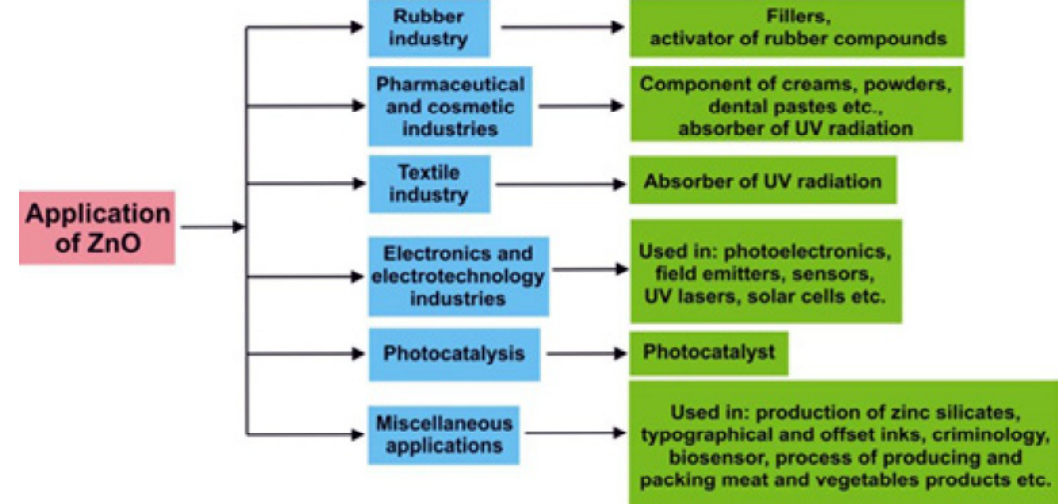
Fig. 11. Schematic representation all the application of ZnO mentioned in the text, reprinted with permis- sion (open access) of Ref [63] Copyright 2014